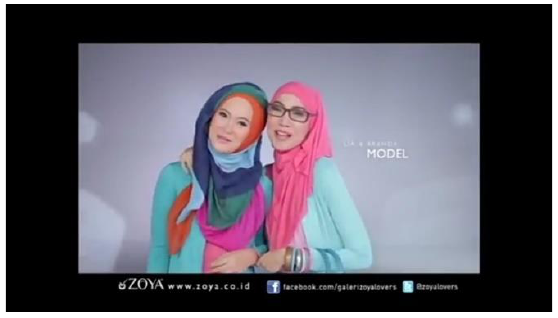
Figure 7: Muslim Women as